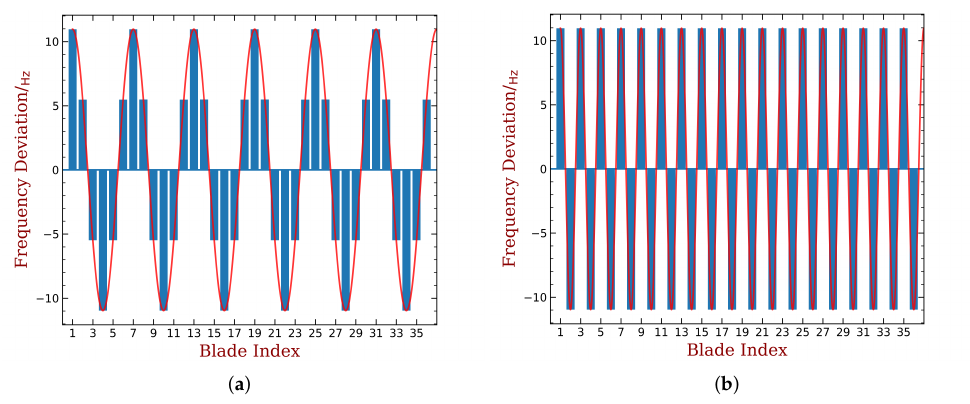
Figure 7. Illustration of some mistuning patterns. ( a ) Wave with h = 6, ( b ) alternate, also wave with h = 18.